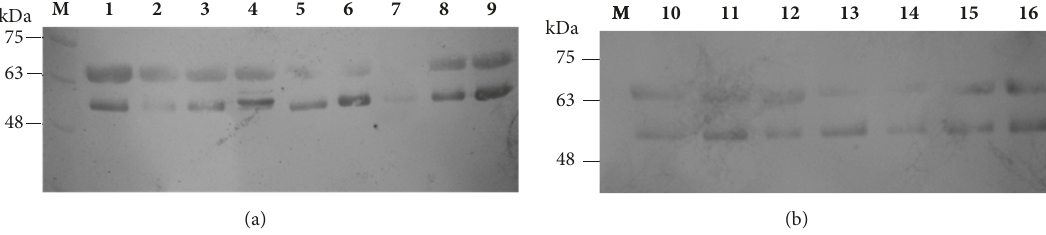
Figure 2: Western blot analysis of proteins using MMP-9 antibody. Proteins were analysed on 10% w/v SDS-polyacrylamide gels. M: prestained protein markers, lanes 1-9 (a) and 10-16 (b): 50 𝜇 g total proteins.